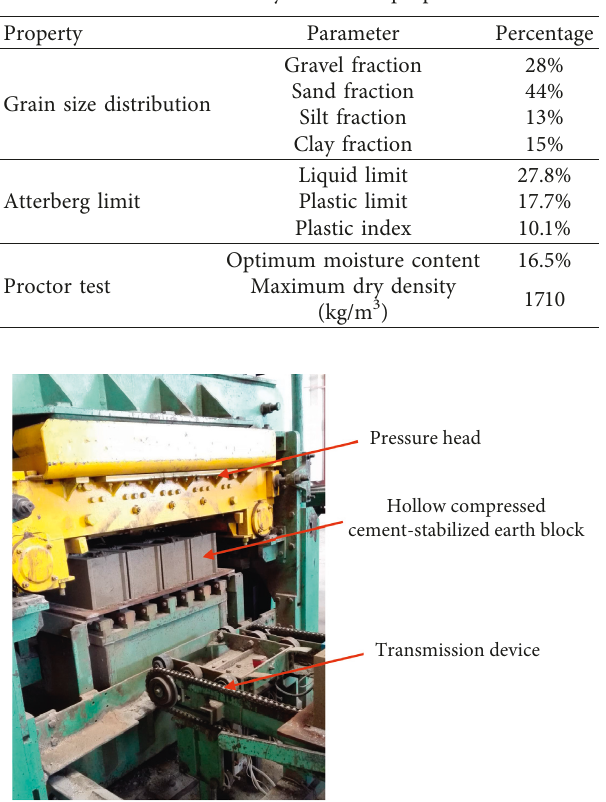
Table 2: Summary of the soil properties.